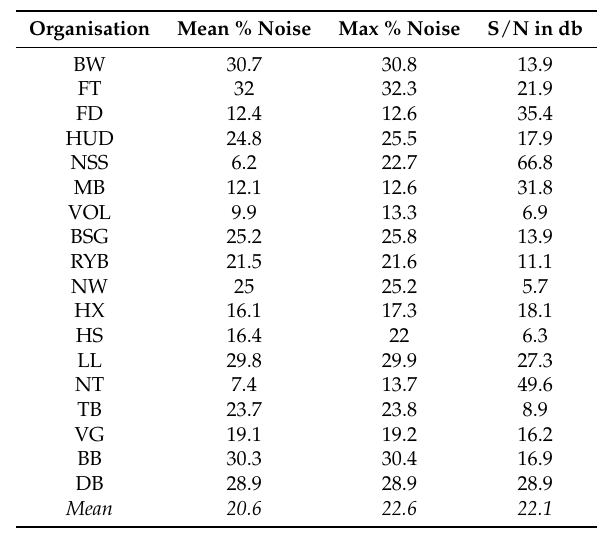
Table 4. Percentage of Noise in Reputation Signals, measured using a Butterworth Filter. The results are means for filter orders between 10 and 25